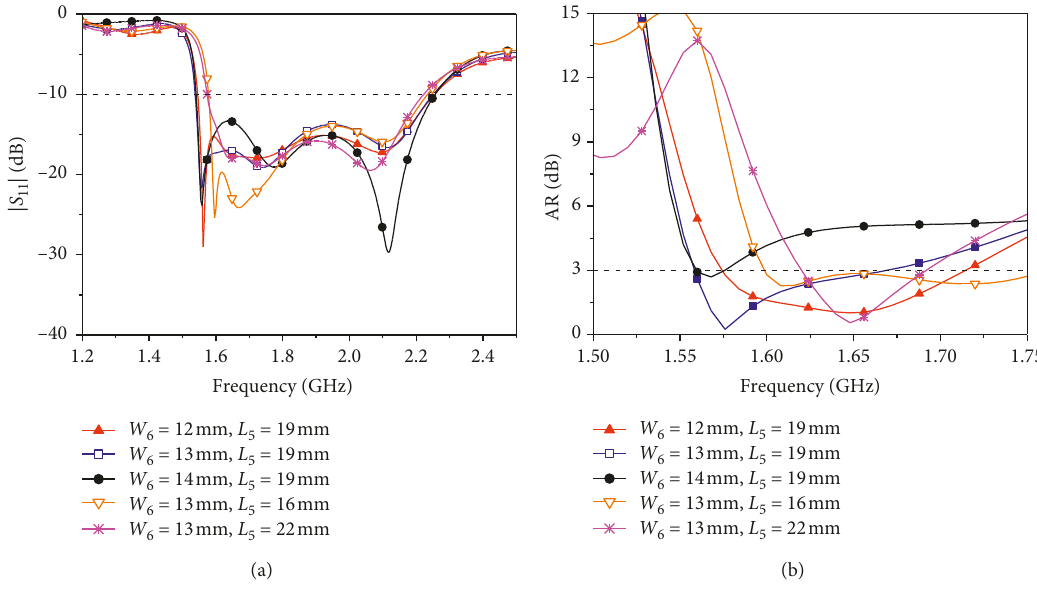
Figure 6: Variations of (a) | S 11 | and (b) AR with different dimensions of the T-shaped strip, W 6 and L 5